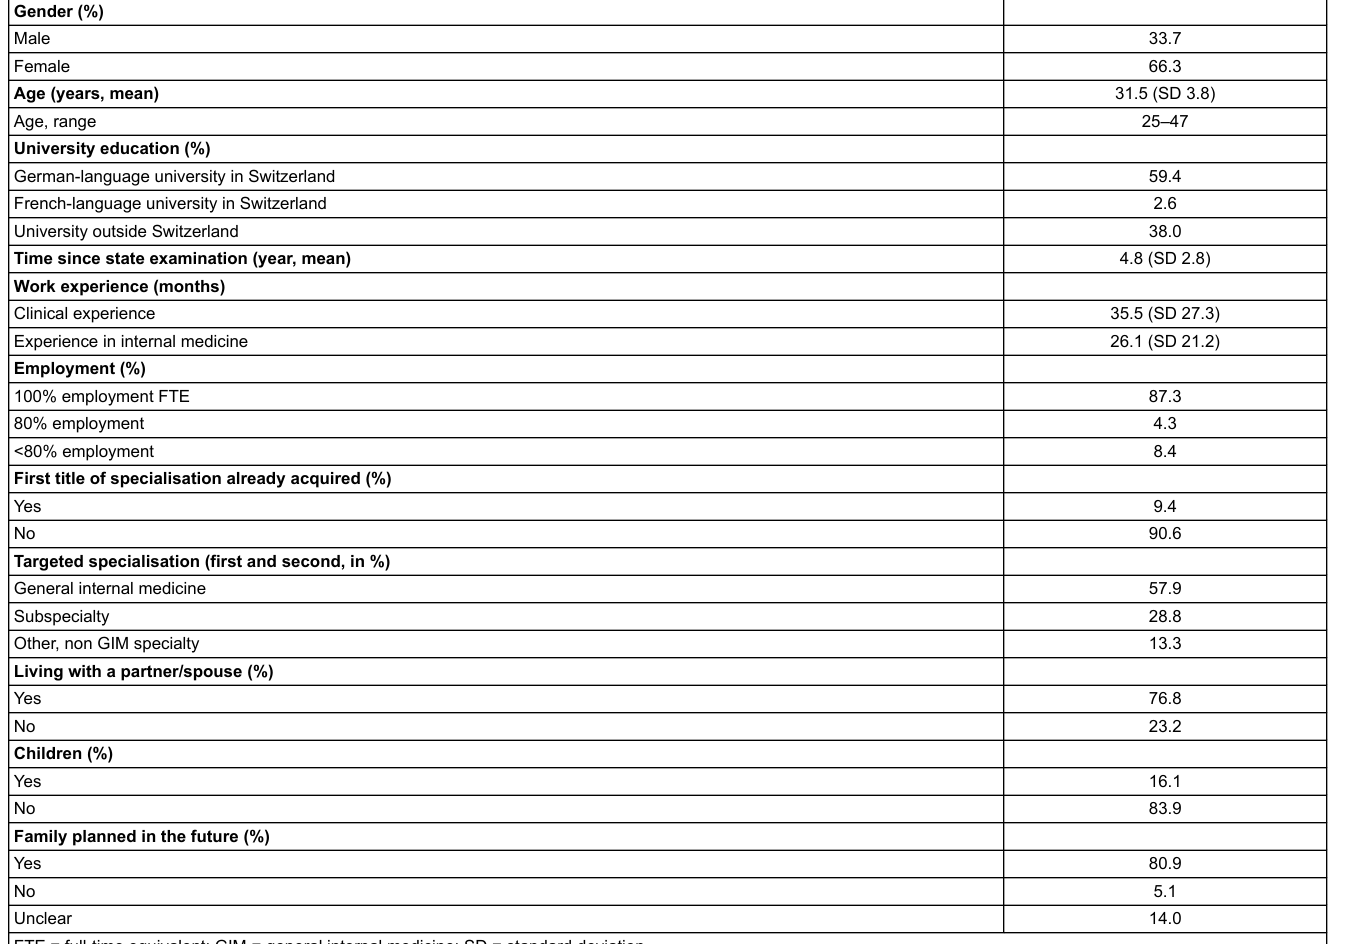
Table 1: Population characteristics of the residents working in a training facility in internal medicine in German-speaking Switzerland and participating in the survey (n = 392). Gender (%)